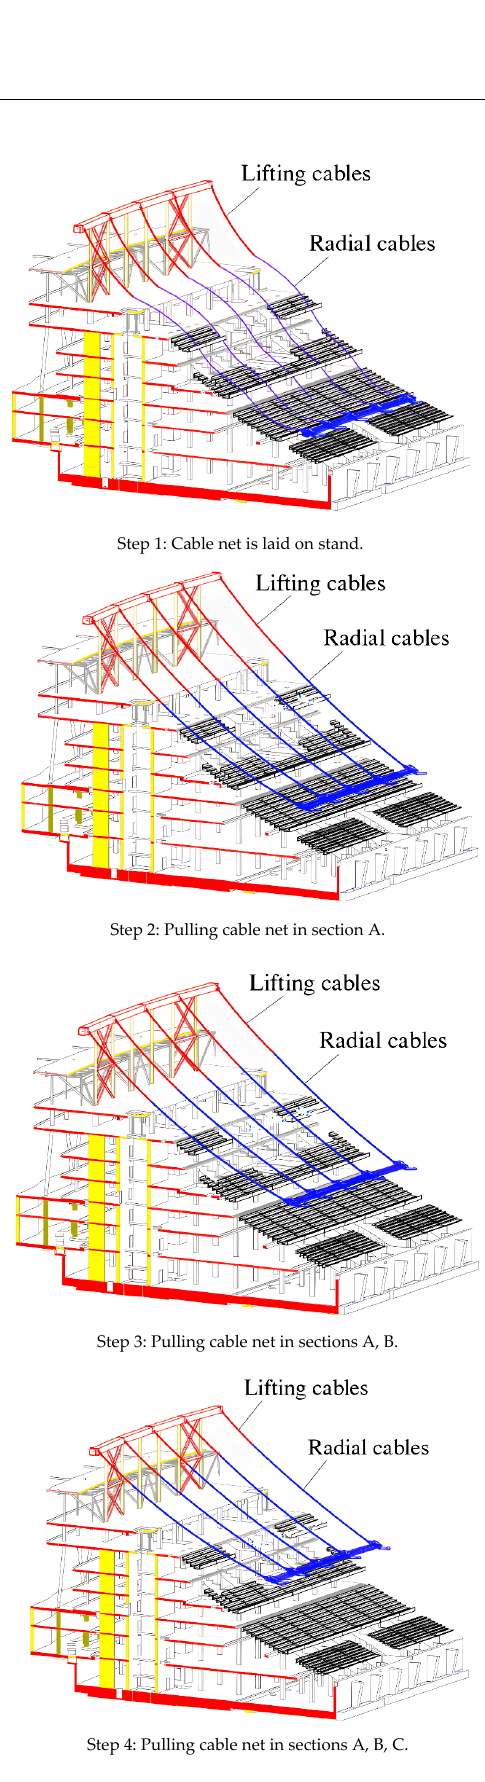
Figure 23. Section division of cable net. The cumulative section traction lifting sequence is shown in Figure 24, in which the red lines represent the traction